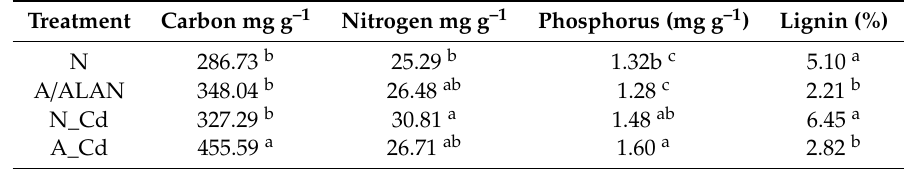
Table 2. Carbon, nitrogen, phosphorus, and lignin contents presented as milligram gram of dry litter